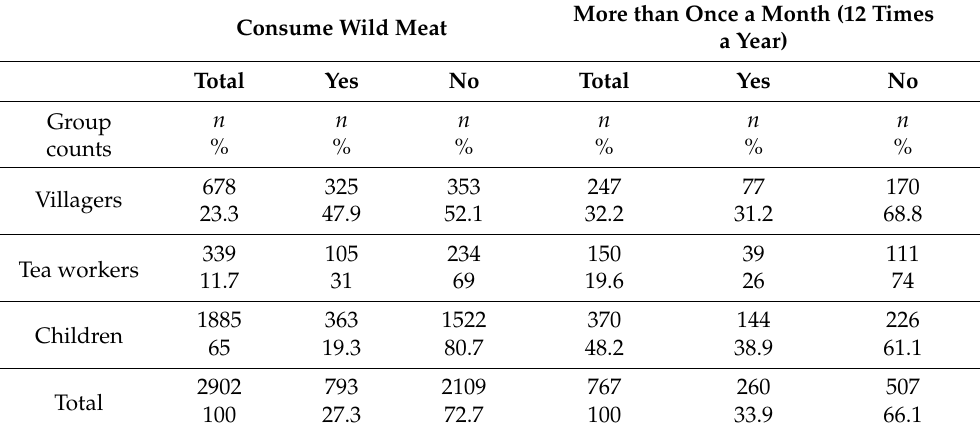
Table 1. Wild meat consumption among group count participants, Sebitoli area, Kibale National Park, Uganda.